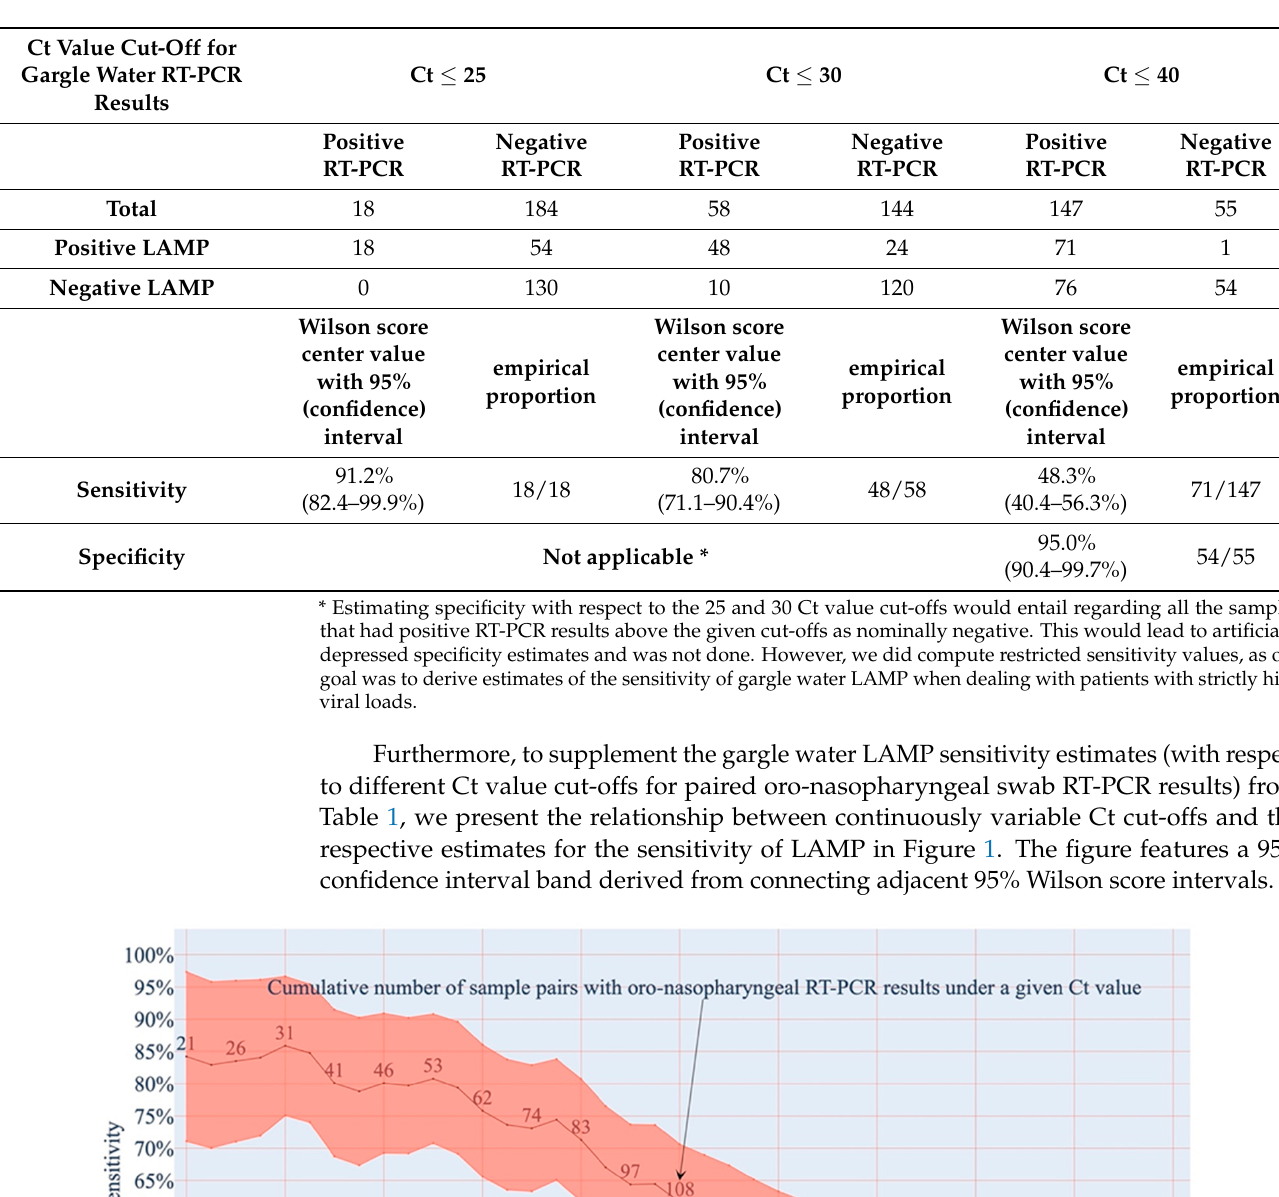
Table 2. The results of gargle water LAMP with respect to Ct value cut ‐ offs for gargle water RT ‐ PCR results.